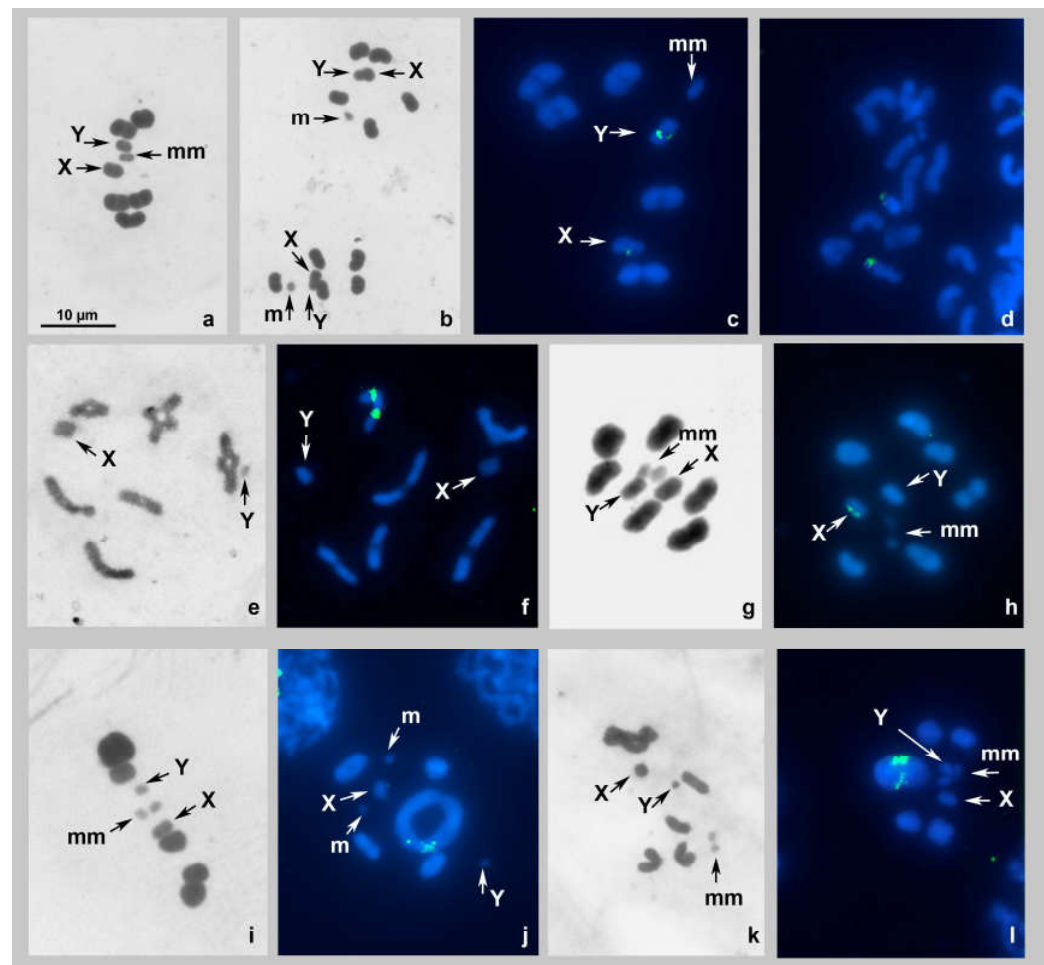
Figure 2. ( a – l ). Karyotypes of species of the family Lygaeidae after Schiff–Giemsa and dou- ble-target FISH with 18S rDNA and telomeric (TTAGG) n probes. ( a – d ) Kleidocerys resedae